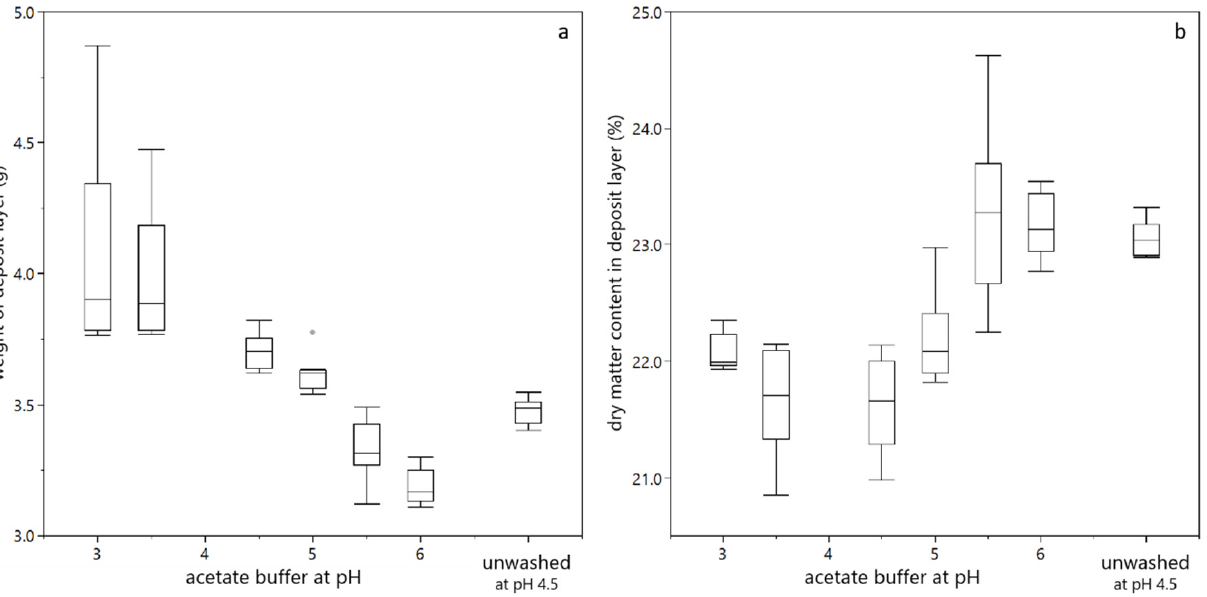
Figure 7. Properties of the deposit layer formed during dead-end filtration of a yeast-BSA mixture with 5% dry matter content: The final weight of the deposit layer including the membrane ( a ) and the dry matter content of the deposit ( b ). All duplicate filtration trials at different transmembrane pressure were considered. The transmembrane pressure had no significant effect on the weight and dry matter content of the deposit layer. Results for the 10% dry matter suspension are comparable, but with a reduced precision of the deposit layer weight, due to handling issues with the quite high